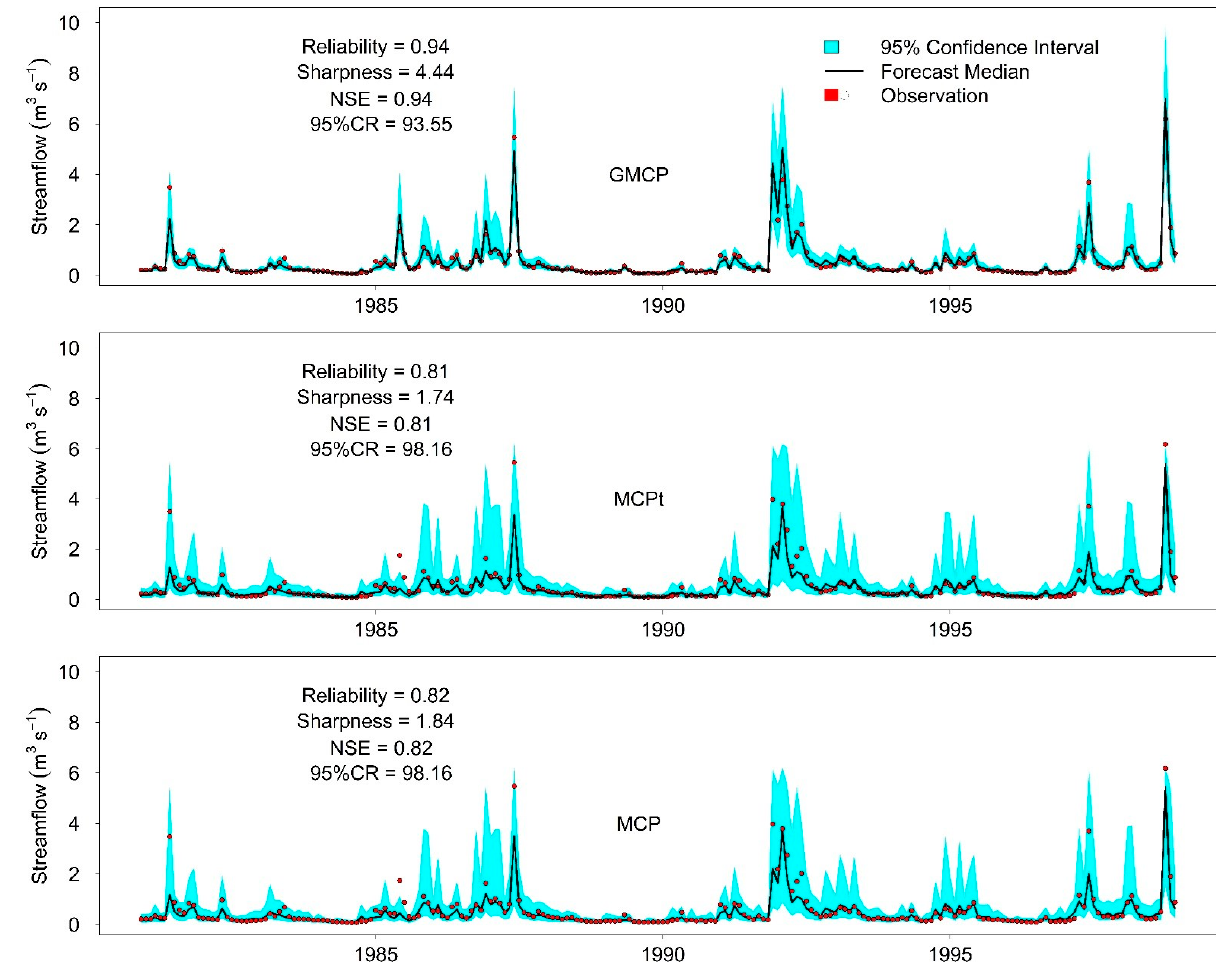
Figure 6. Time series of the median and 95% confidence interval of monthly streamflow predictions derived from the Gaussian mixture clustering post-processor (GMCP), model conditional proces- sor (MCP), and MCP using the truncated Normal (MCPt), compared with observations from the validation period (1980–1998) in the San Marcos catchment